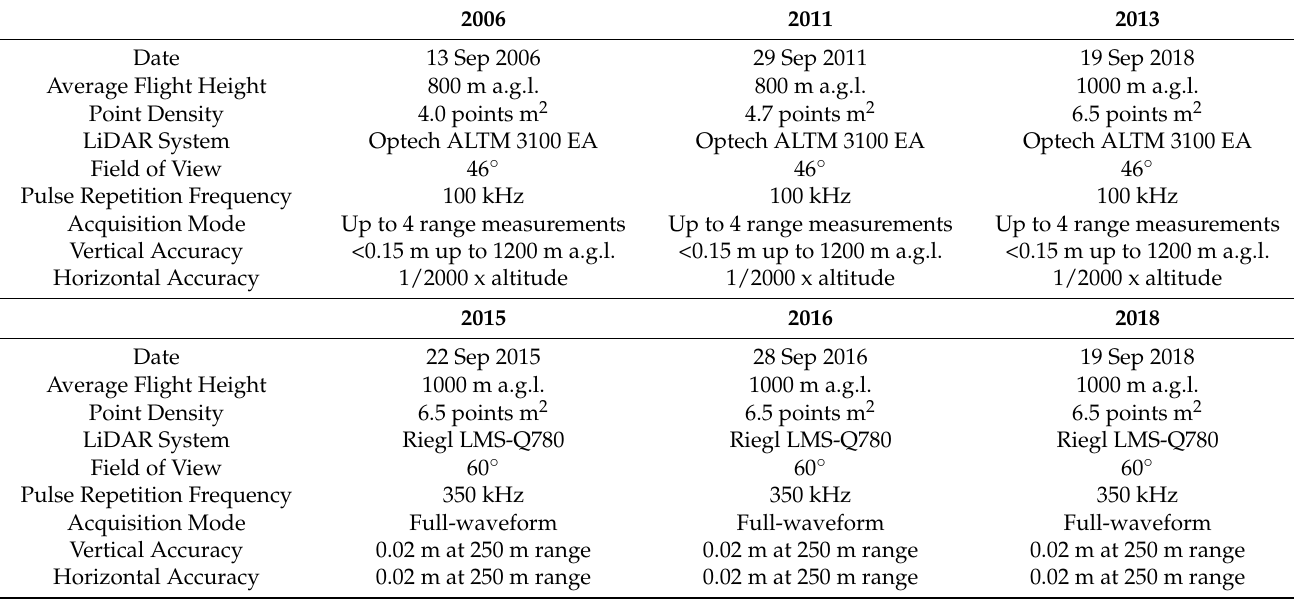
Table 1. Technical specifications of the LiDAR surveys performed in the study area between 2006 and